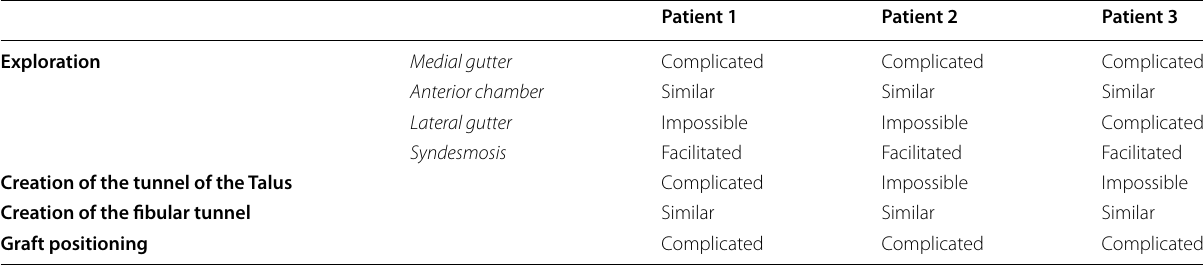
Table 3 Interest in using the NanoScopeTM at different